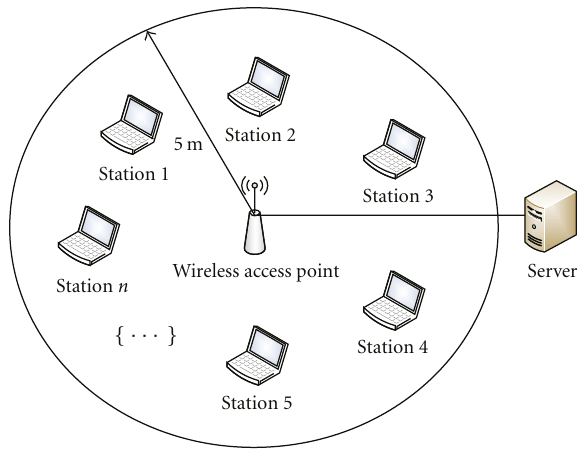
Figure 3: Network topology used in ns-2